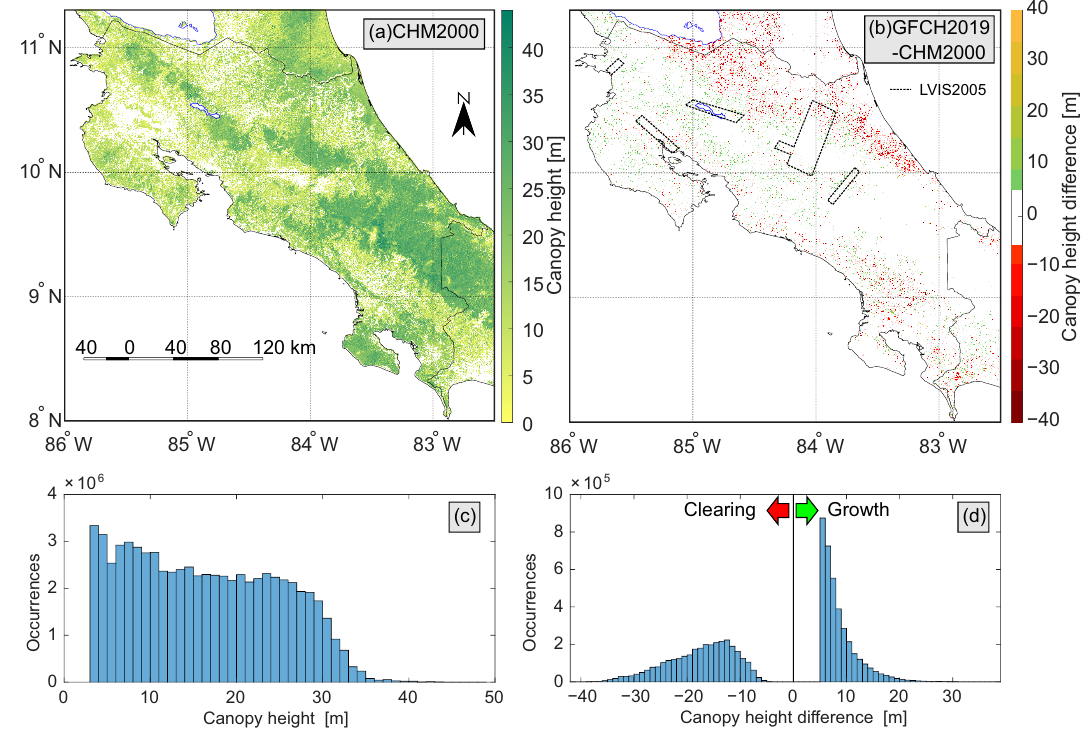
Figure 9. ( a ) Canopy Heights Model CHM2000. ( b ) Difference in canopy heights between GFCH2019 and CHM2000. ( c ) Histogram of canopy heights for CHM2000; the min/max/mean height is 3/49/15.8 m, as in GFCH2019. ( d ) Histogram of the differences in canopy heights between GFCH2019 and CHM2000; the min/max differences are − 42/39